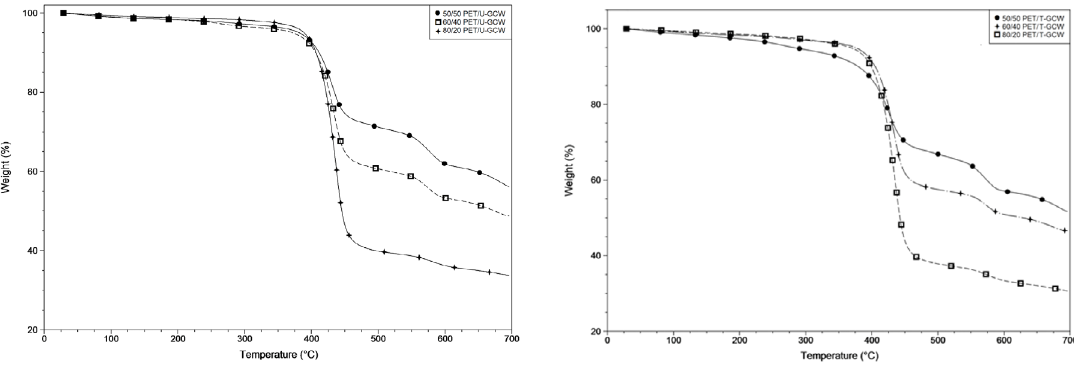
Figure 9. Overlay of the TG curves of PET/T-GCW